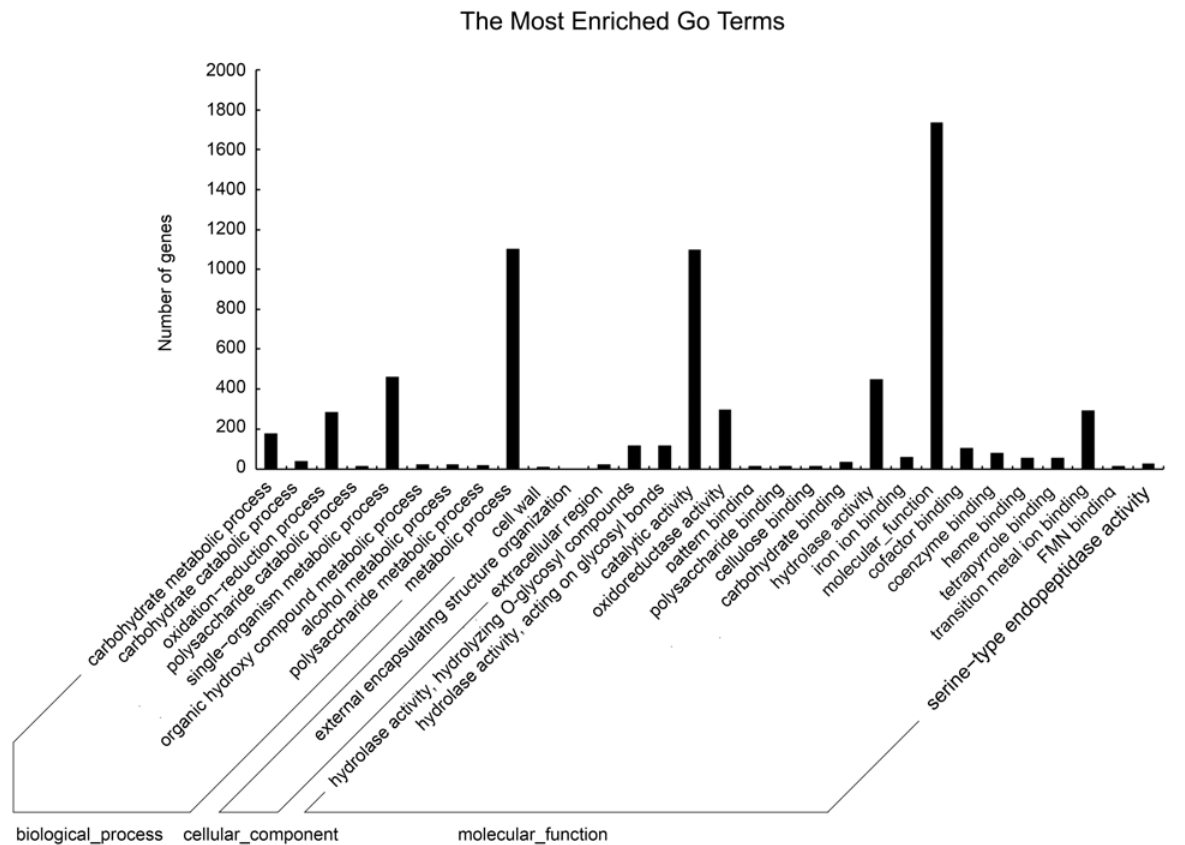
Fig 3. Functional annotation of DEGs based on gene ontology (GO) categorization. Each annotated sequence was assigned at least one GO term.